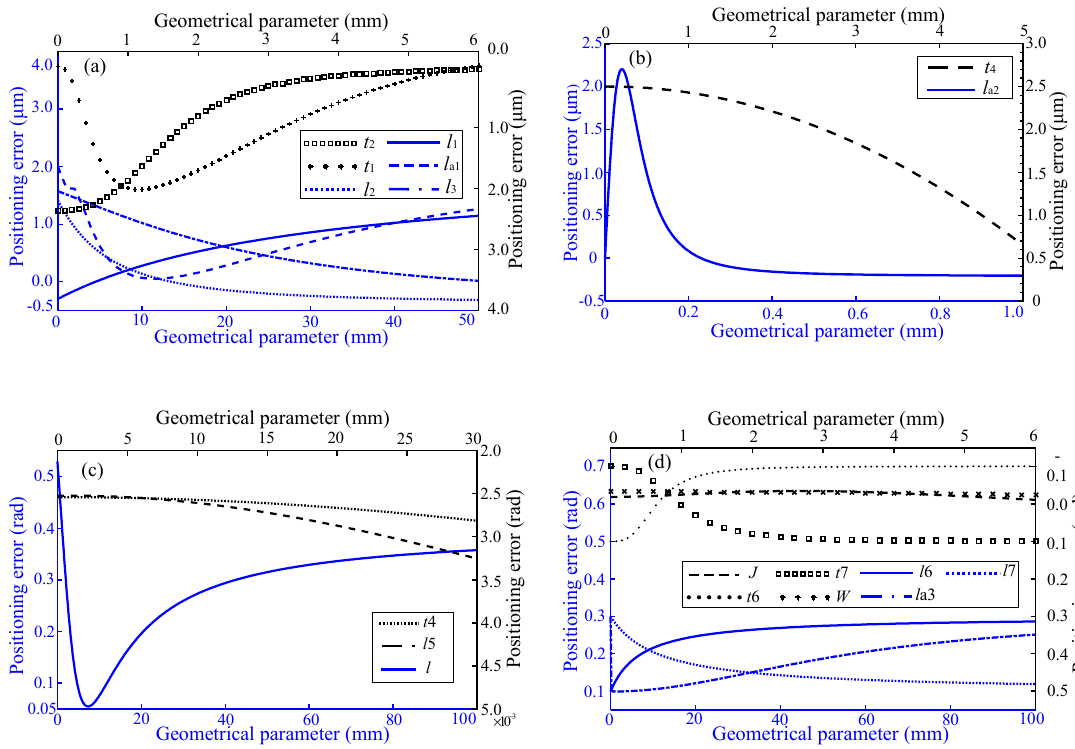
Figure 7. Machining error results for ( a ) moving along X / Y axis, ( b ) moving along Z axis, ( c ) rotating along X / Y axis, and ( d ) rotating along Z axis.